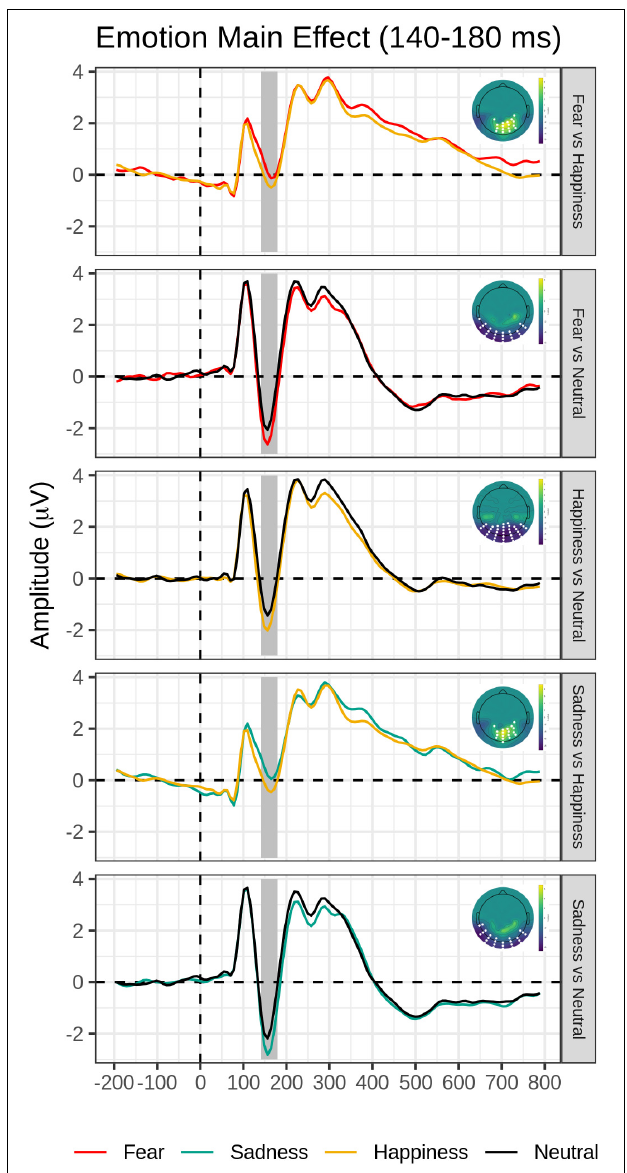
FIGURE 2 | Emotion main effect in the early time window (140–180 ms): Grand-average waveforms of the electrodes included in the significant negative or positive clusters and the scalp topography of the significant clusters (with the significant electrodes highlighted in white). Covert and Overt tasks are combined.